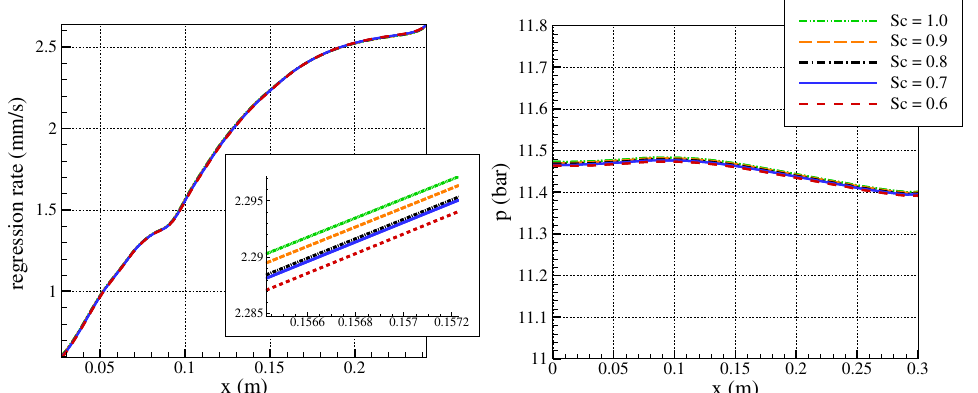
Figure 10. Effect of the laminar Schmidt number on regression rate and